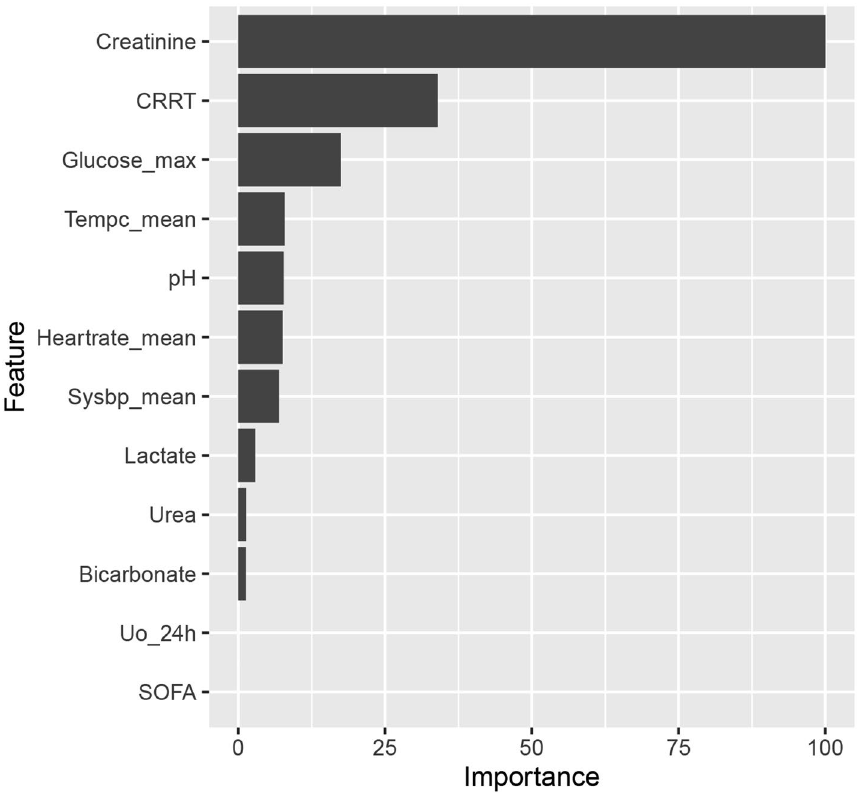
Figure 4. Variable-importance ranking in the gradient-boosting machine. RRT, renal replacement therapy; SOFA, Sepsis-related Organ Failure Assessment; Uo_24h, urine volume for 24 h on ICU